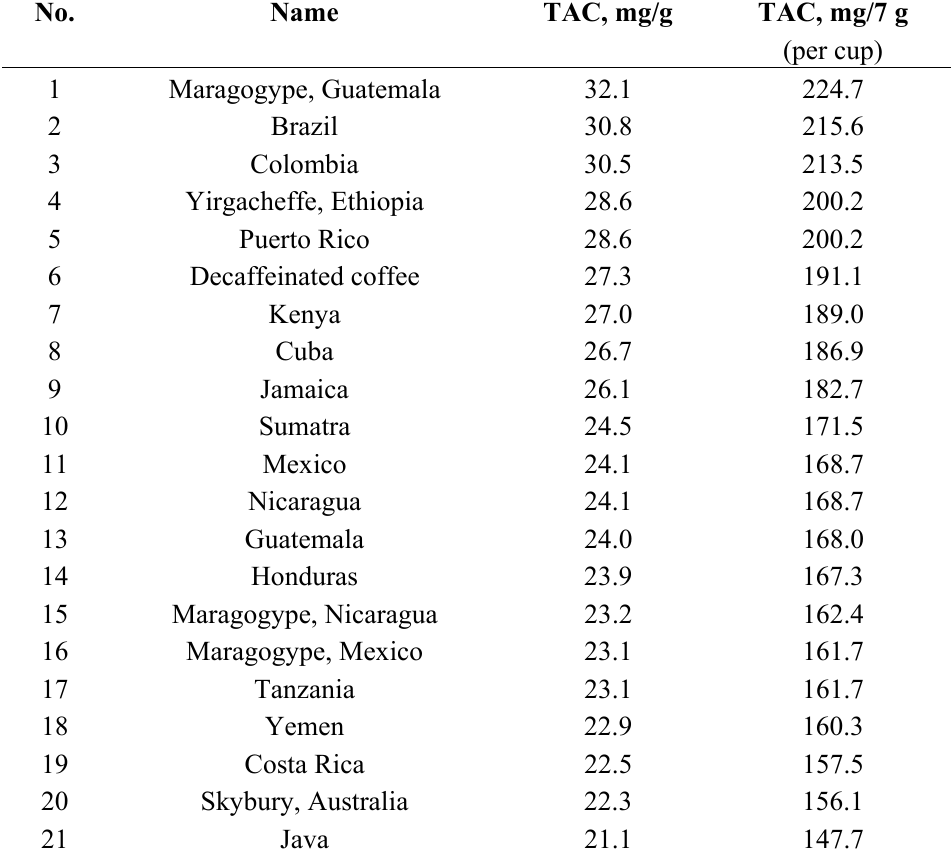
Table 9. The total content of antioxidants (TAC) in MADEO coffee beans provided by company “Freshly Roasted Coffee” (quercetin used as standard) [41,50].